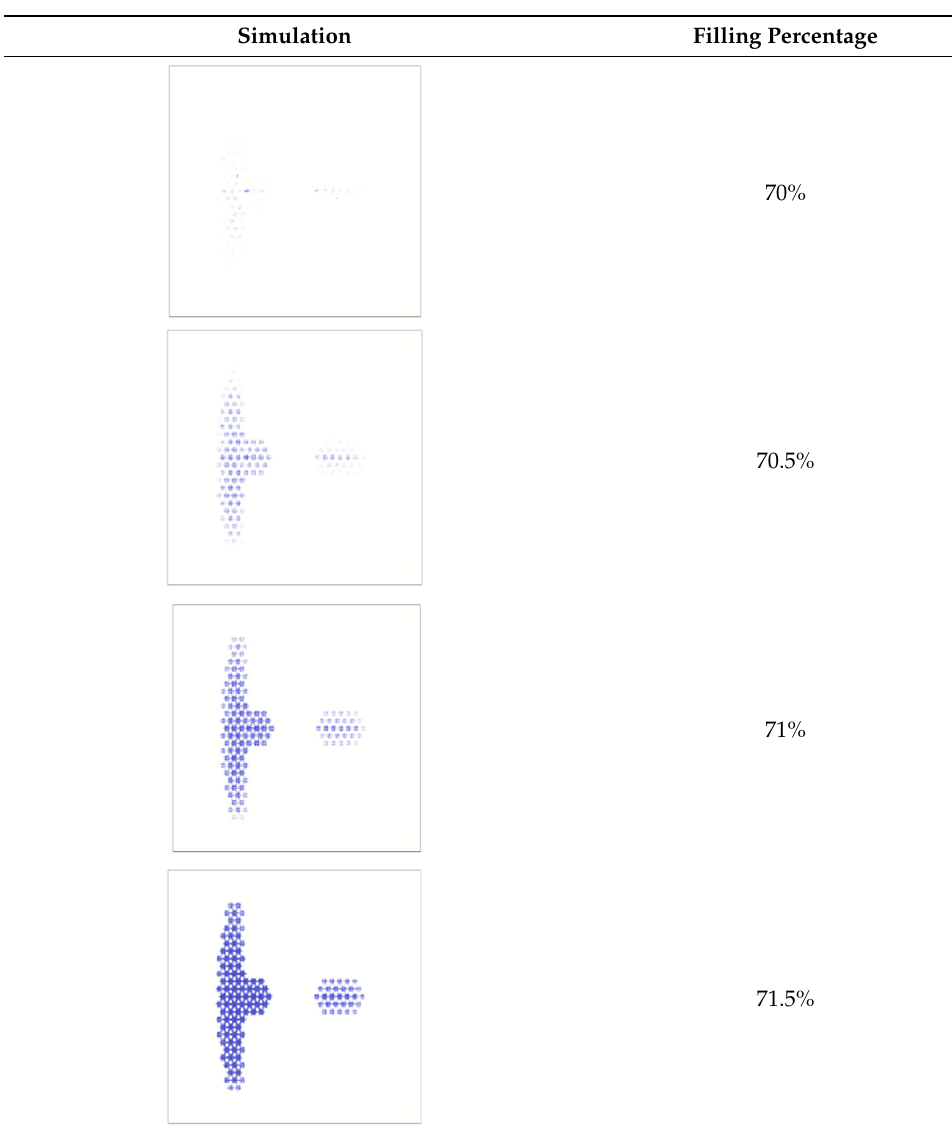
Table 7. The simulation results of the Case 2 flow trend on the plate.